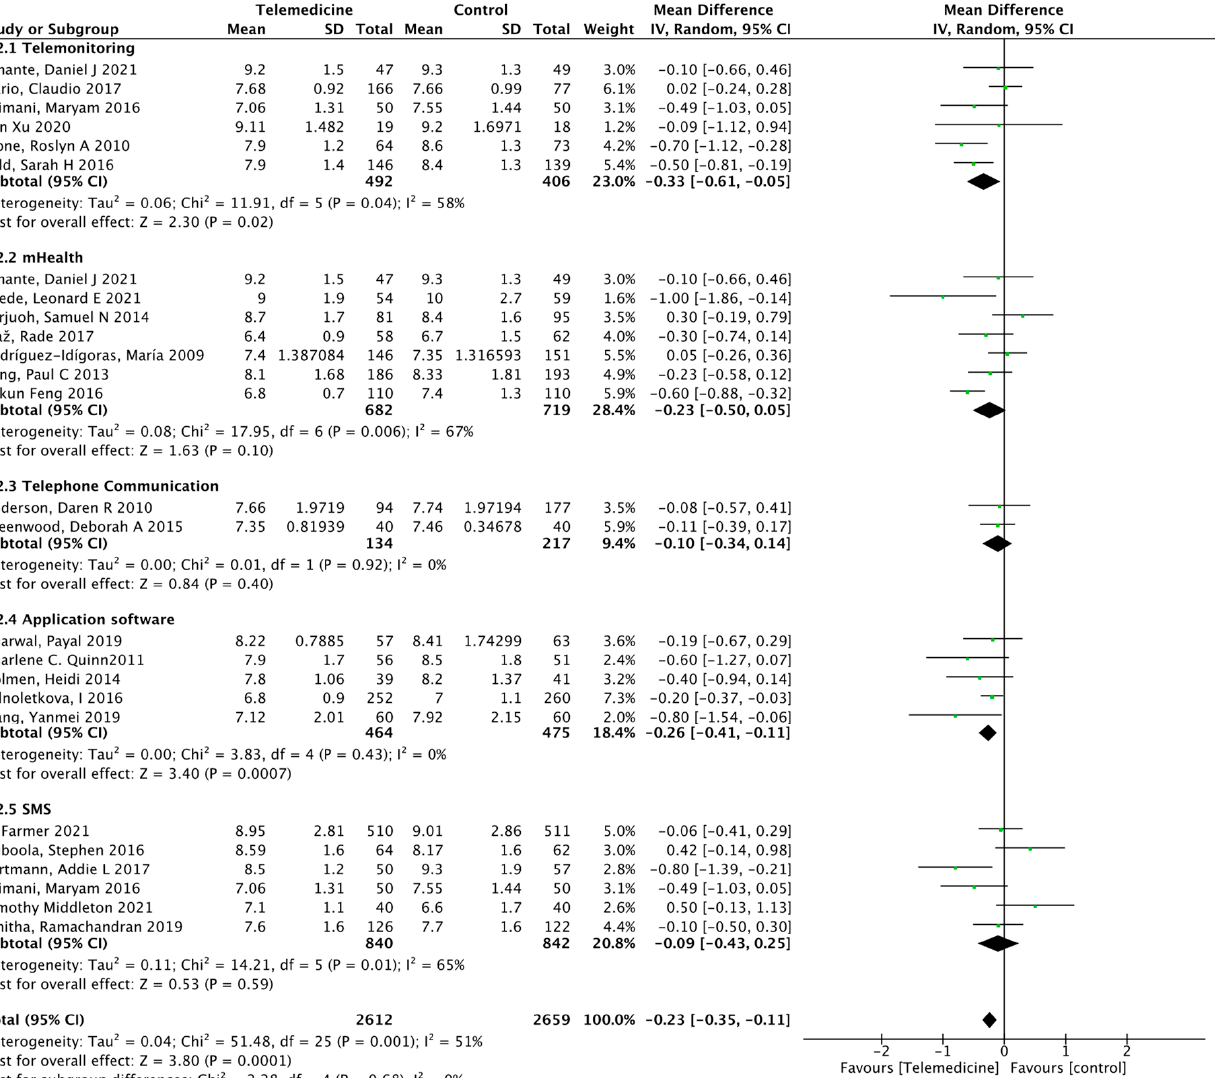
Figure 5. Subgroup analysis showed higher HbA1c reductions in patients with remote monitoring and application interventions.